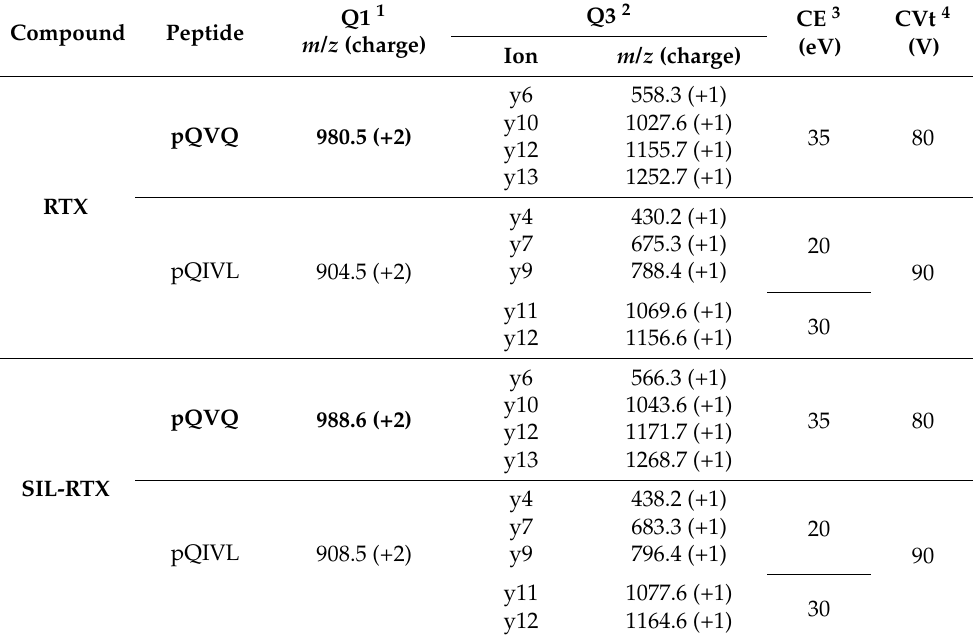
Table 2. Surrogate peptides pre-selected for Rituximab (RTX) quantification by LC-MS/MS using the full-length stable isotope-labeled rituximab (SIL-RTX). Peptide in bold was used for the